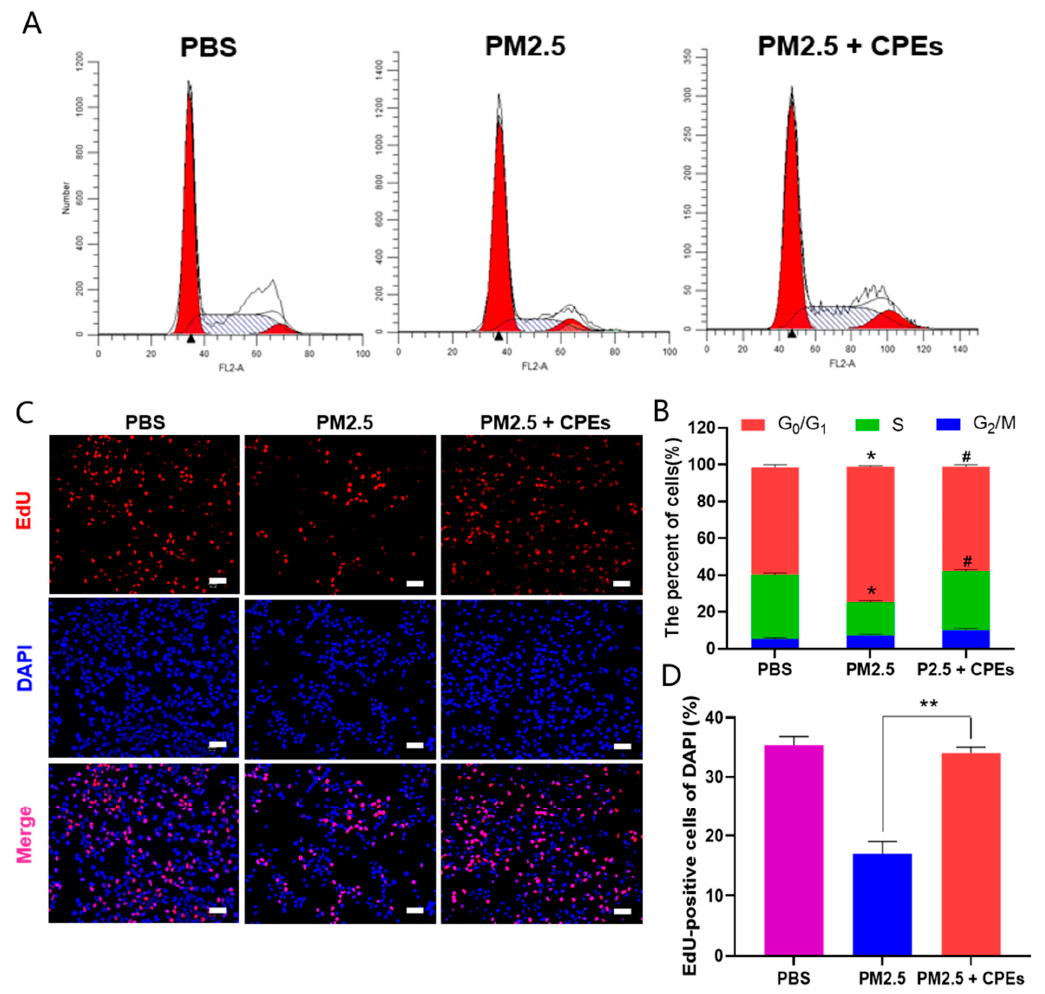
Figure 5. E ff ects of PM2.5 and CPEs on proliferation ability of fi broblasts . Cells were treated with PM2.5 (100 µg mL − 1 ) or plus CPEs (10 mg mL − 1 ) for 24 h. ( A ) Flow cytometry was used to analyze the changes in the cell cycle after PM2.5 or plus CPE treatment. ( B ) CPEs increased the proportion of S-phase cells resulting from PM2.5 treatment. ( C ) 5-ethynyl-2 ′ -deoxyuridine staining (EdU, red) was used to indicate S-phase cells, and DAPI (blue) was used for nuclei staining (scale bar: 40 µm). ( D ) Proliferation rate was significantly restored from the CPE-treated groups. All results are expressed as mean ± SD of three biological replicates. ( B ) * p < 0.05 compared with PBS; # p < 0.05 compared with PM2.5. ( D ) ** p < 0.01 compared with PM2.5.